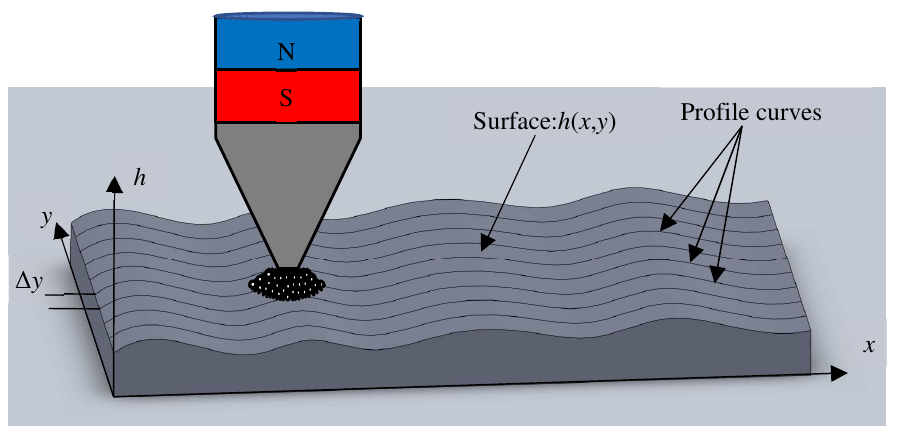
Figure 2. The principle of corrective magnetic abrasive finishing.